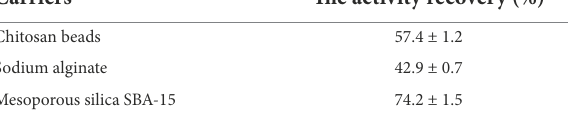
TABLE 1 The activity recovery of the immobilizing Est882 on different